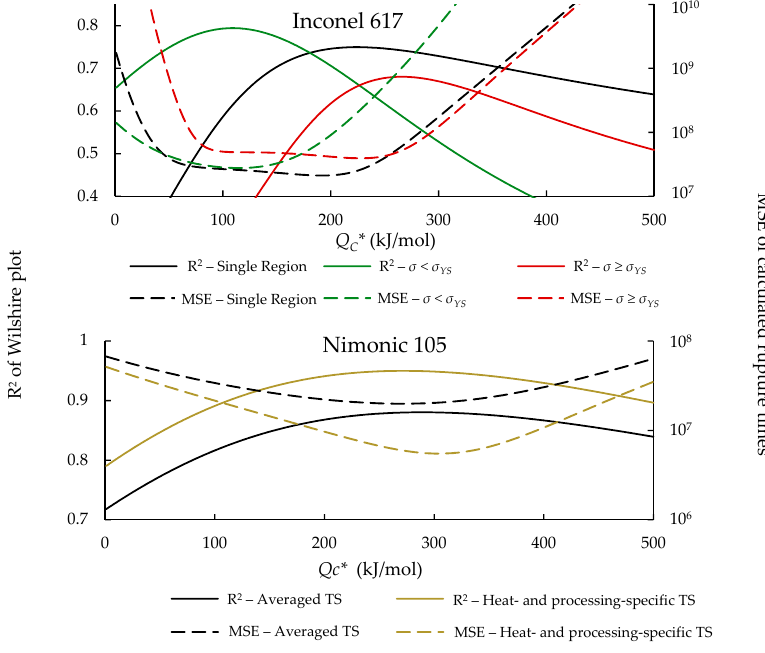
2 and MSE vs. Q ∗ Figure 2. R 2 and MSE vs. (cid:1843) (cid:3004)∗ for all data. Figure 2. R